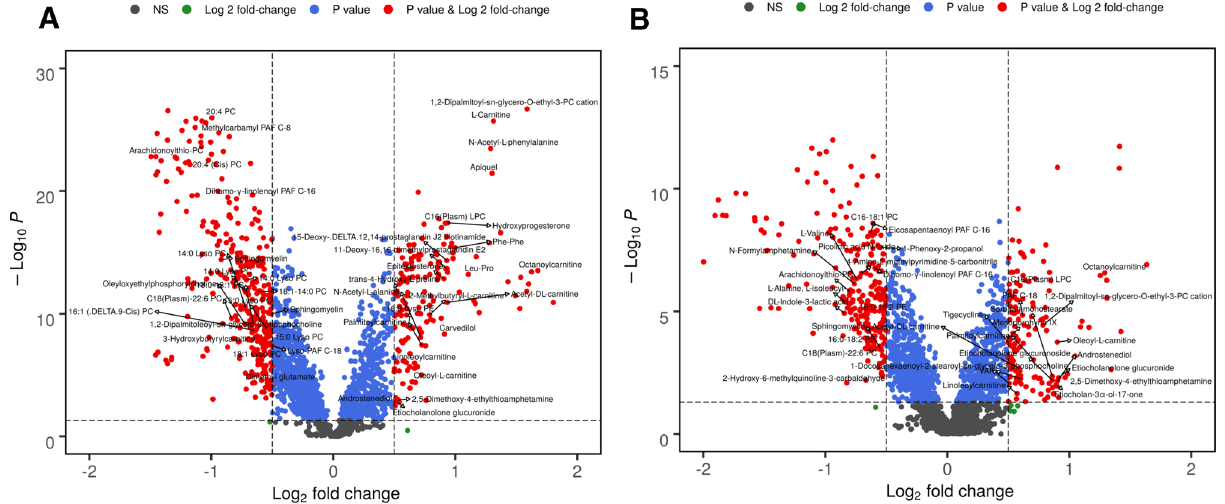
Figure 3. Volcano plot showing comparison of NHP serum profiles at SD1 ( A ) and SD4 ( B ). All annotated metabolites were validated by tandem mass spectrometry and have a significant FDR adjusted p value (< 0.05) comparing pre-irradiation vs. radiation. Figure is created by open source software R (version 4.0.3, URL: https:// cran.r- proje ct.